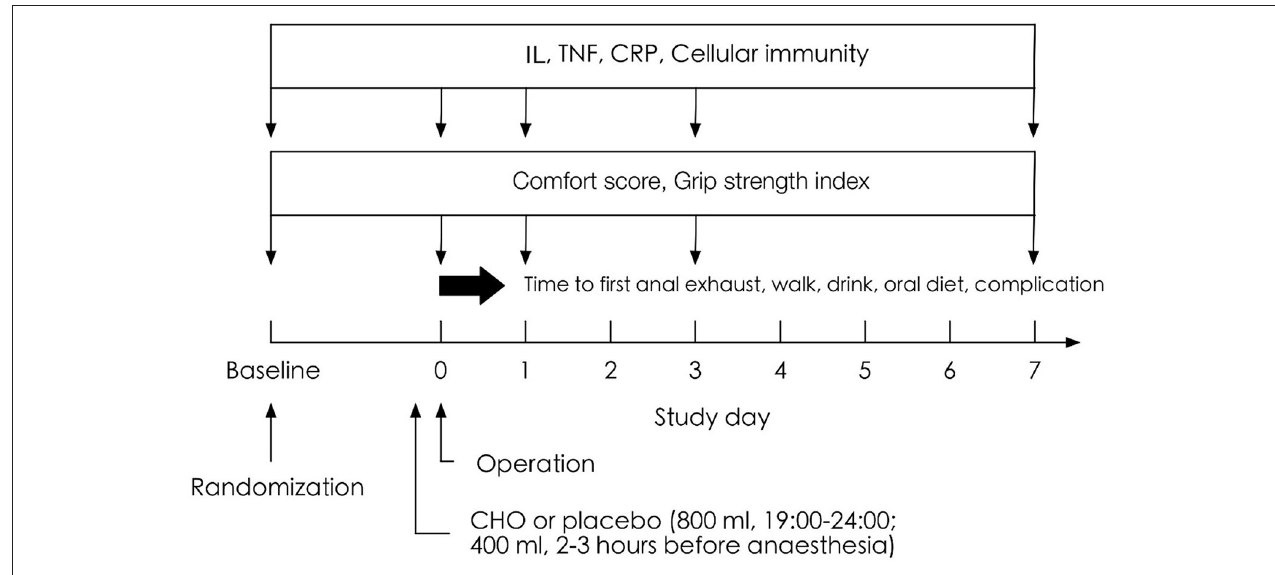
FIGURE 1 | Illustration of the experimental